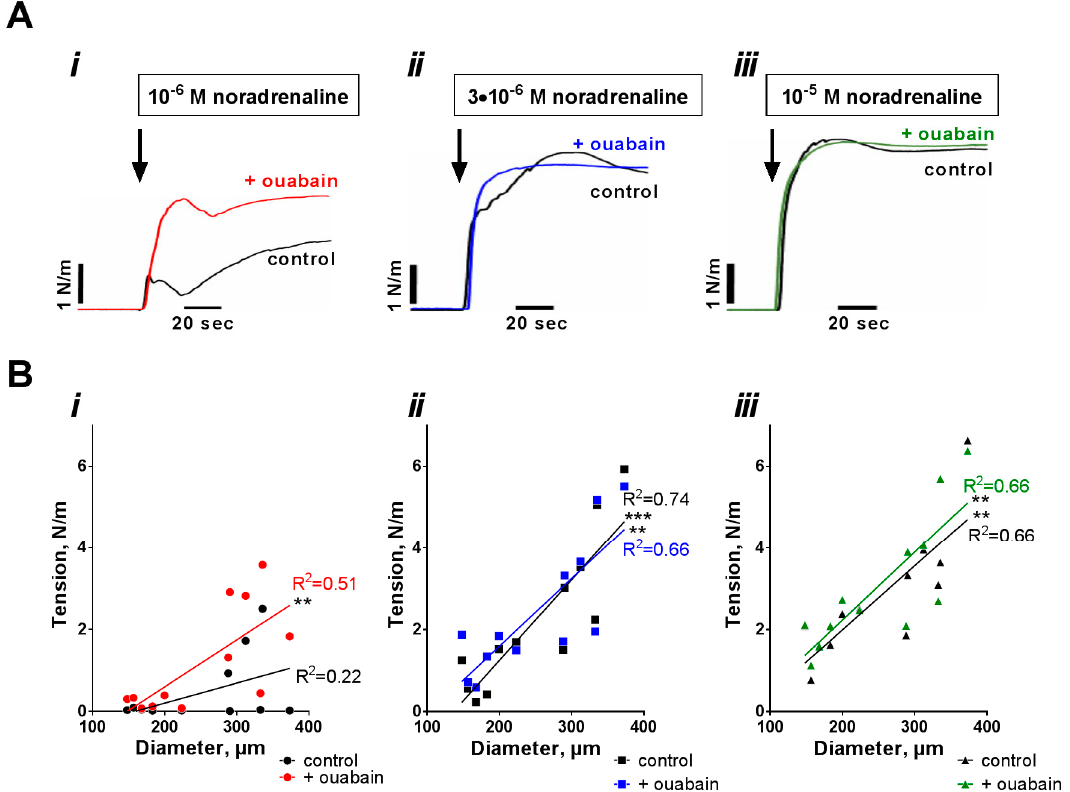
Figure 2. The potentiating effect of ouabain on noradrenaline-induced contraction depends on arterial diameter. Wall tension changes of mesenteric arteries of different diameters was assessed in response to stimulation with either 1 µ M ( i ), 3 µ M ( ii ) or 10 µ M ( iii ) noradrenaline. Note, these wall tensions were measured simultaneously with [Ca 2+ ] i , as shown in Figure 3. The stimulations were then repeated after 15 min incubation with 10 µ M ouabain. Representative curves for wall tension responses are shown in ( A ). ( B ) shows averaged noradrenaline-induced changes in wall tension correlated with arterial diameter. Linear regression quantifies goodness of fit with R 2 as indicated by the lines. p < 0.01 (**) and p <0.001 (***), n = 12.